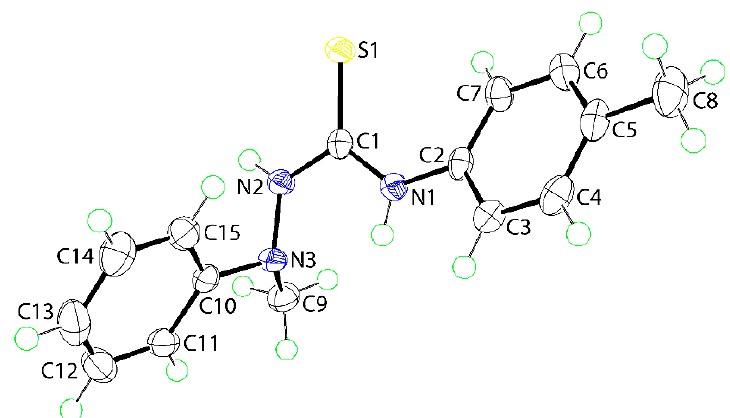
Figure 1. The molecular structure of ( 1 ) showing atom labeling and displacement ellipsoids at the 70% probability level. Selected geometric parameters: C1–S1 = 1.6895(13) Å, N2–N3 = 1.4081(15) Å, C1–N1 = 1.3491(16) Å, and C1–N2 = 1.3458(16) Å; C1–N1–C2 = 129.77(11)°, C1–N2–N3 = 122.11(11)°, S1–C1– N1 = 127.50(10)°, S1–C1–N2 = 117.36(9)°, and N1–C1–N2 = 115.14(11)°.